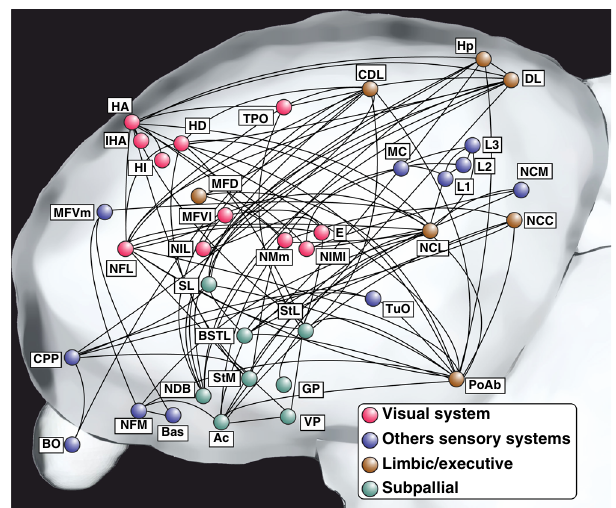
Fig. 5 Schematic depiction of the telencephalic network in the pigeon brain active during our color discrimination experiment. Nodes represent active regions in the “ Go > NoGo + mandibulation ” contrast (for more details see Fig. 3 and Supplementary Fig. 6). Nodes are colored based on their involvement in different functional networks. Note that the activated networks are spatially distributed rather than localized. For abbreviations see Supplementary Table